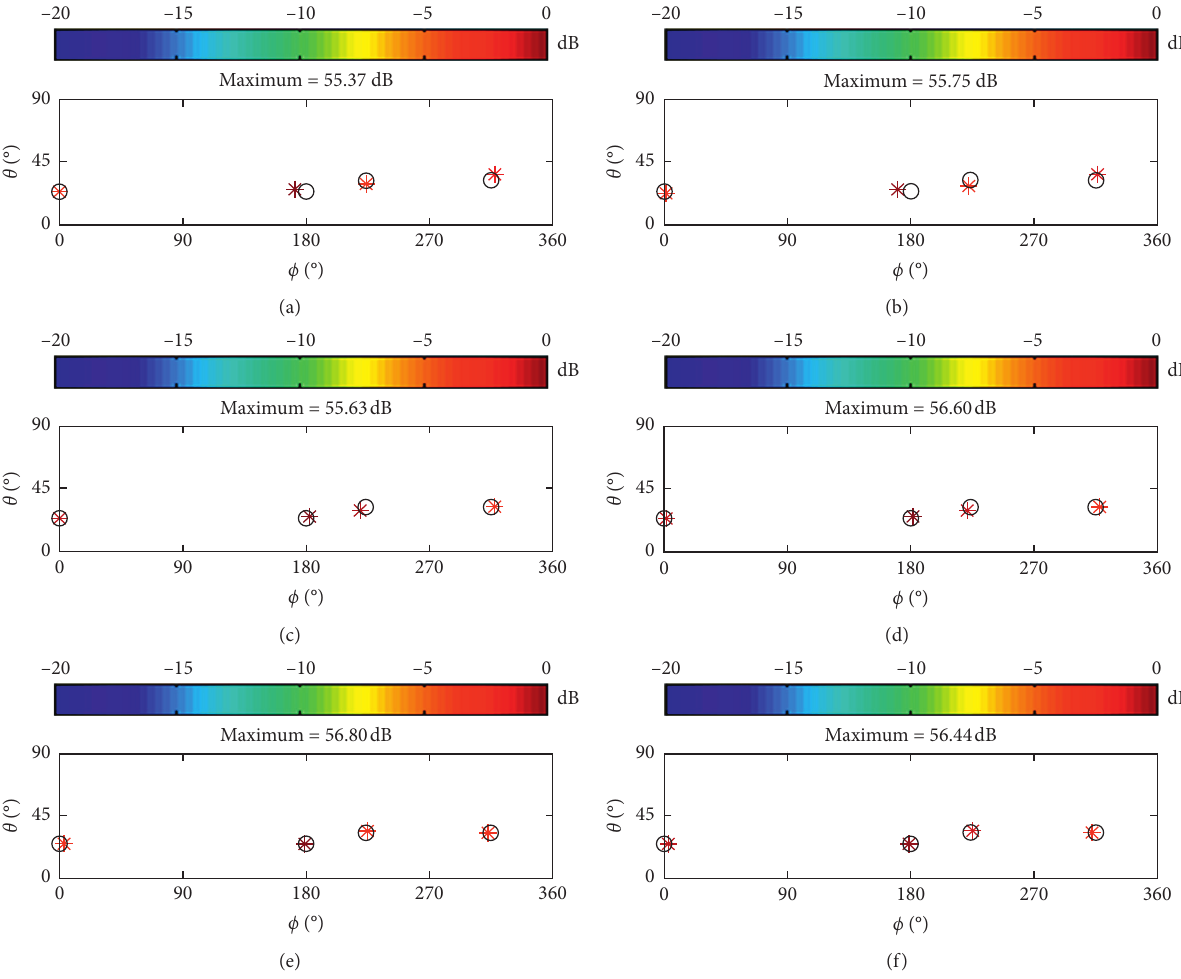
Figure 5: Loudspeaker source maps at (a), (b) 2000Hz, (c), (d) 3000Hz and (e), (f) 4000Hz obtained by the two-dimensional multiple- snapshot grid-free compressive beamforming using (a), (c), (e) the IPM based SDPT3 solver and (b), (d), (f) our ADMM based algorithm. The standard uniform rectangular array with 64 microphones is employed. In each map, the reconstructed output ( ∗ ) is scaled to dB by referring to its maximum, the reconstructed maximum referring to 2 × 10 − 5 Pa is labeled on the top, and the symbols ○ indicate the true DOAs but do not contain the strength information, so do in Figure